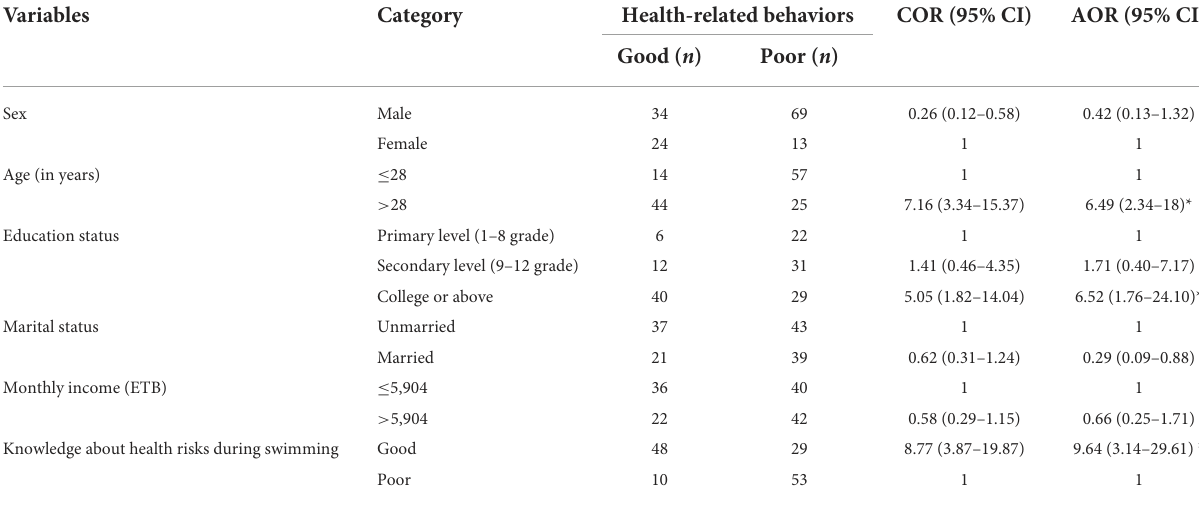
TABLE 4 Factors affecting swimming pool users’ health-related behaviors in Kombolcha Town, Northeastern Ethiopia, 2021.